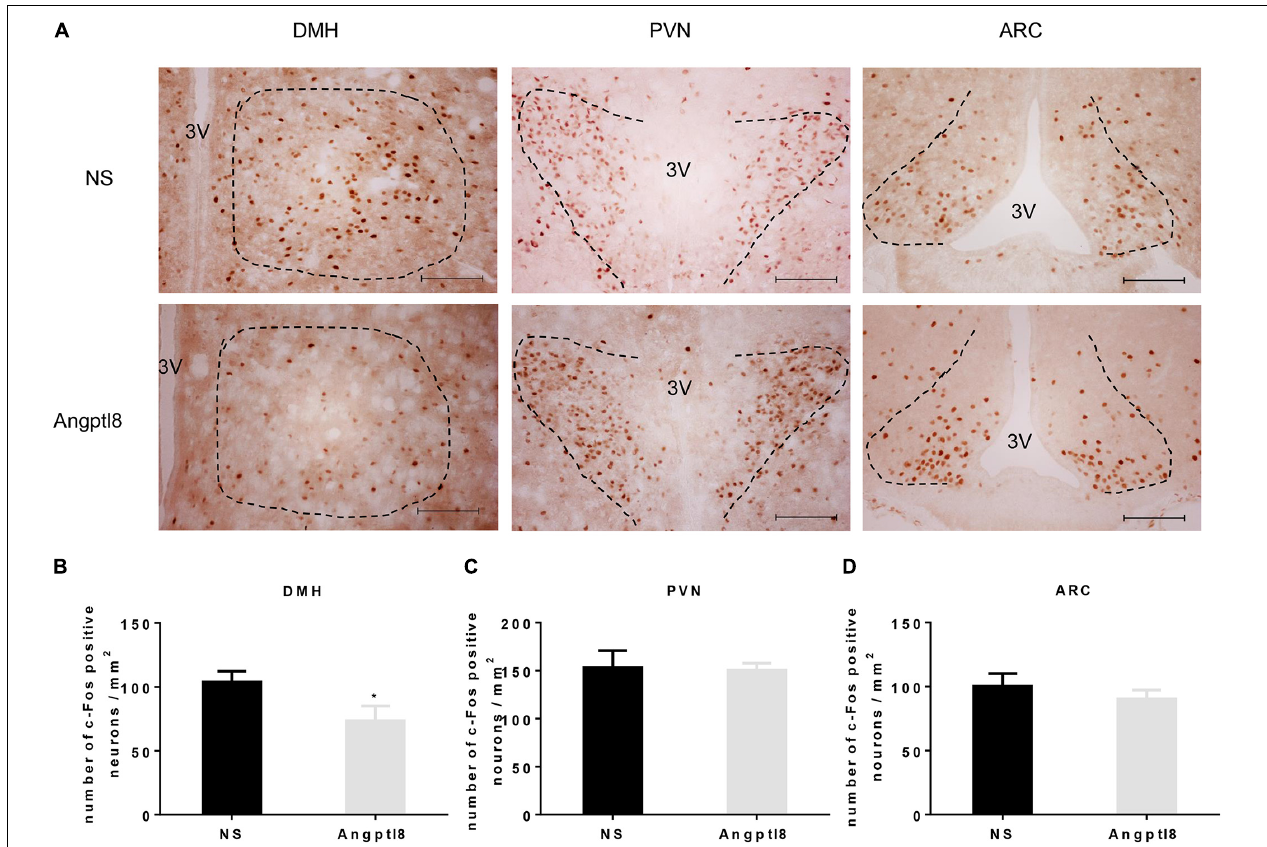
FIGURE 3 | Peripheral Angptl8 decreased c-Fos-positive neurons expression in the DMH of the hypothalamus. (A) c-Fos-positive neurons change in hypothalamus 2 h after tail intravenous injection with NS and Angptl8. (B–D) The numbers of c-Fos-immunopositive cells in the DMH ( n = 8), PVN ( n = 6), and ARC ( n = 8) are expressed as means ± SEM. ∗ P < 0.05 relative to the NS control group. Scale bar in A = 100 µ m.